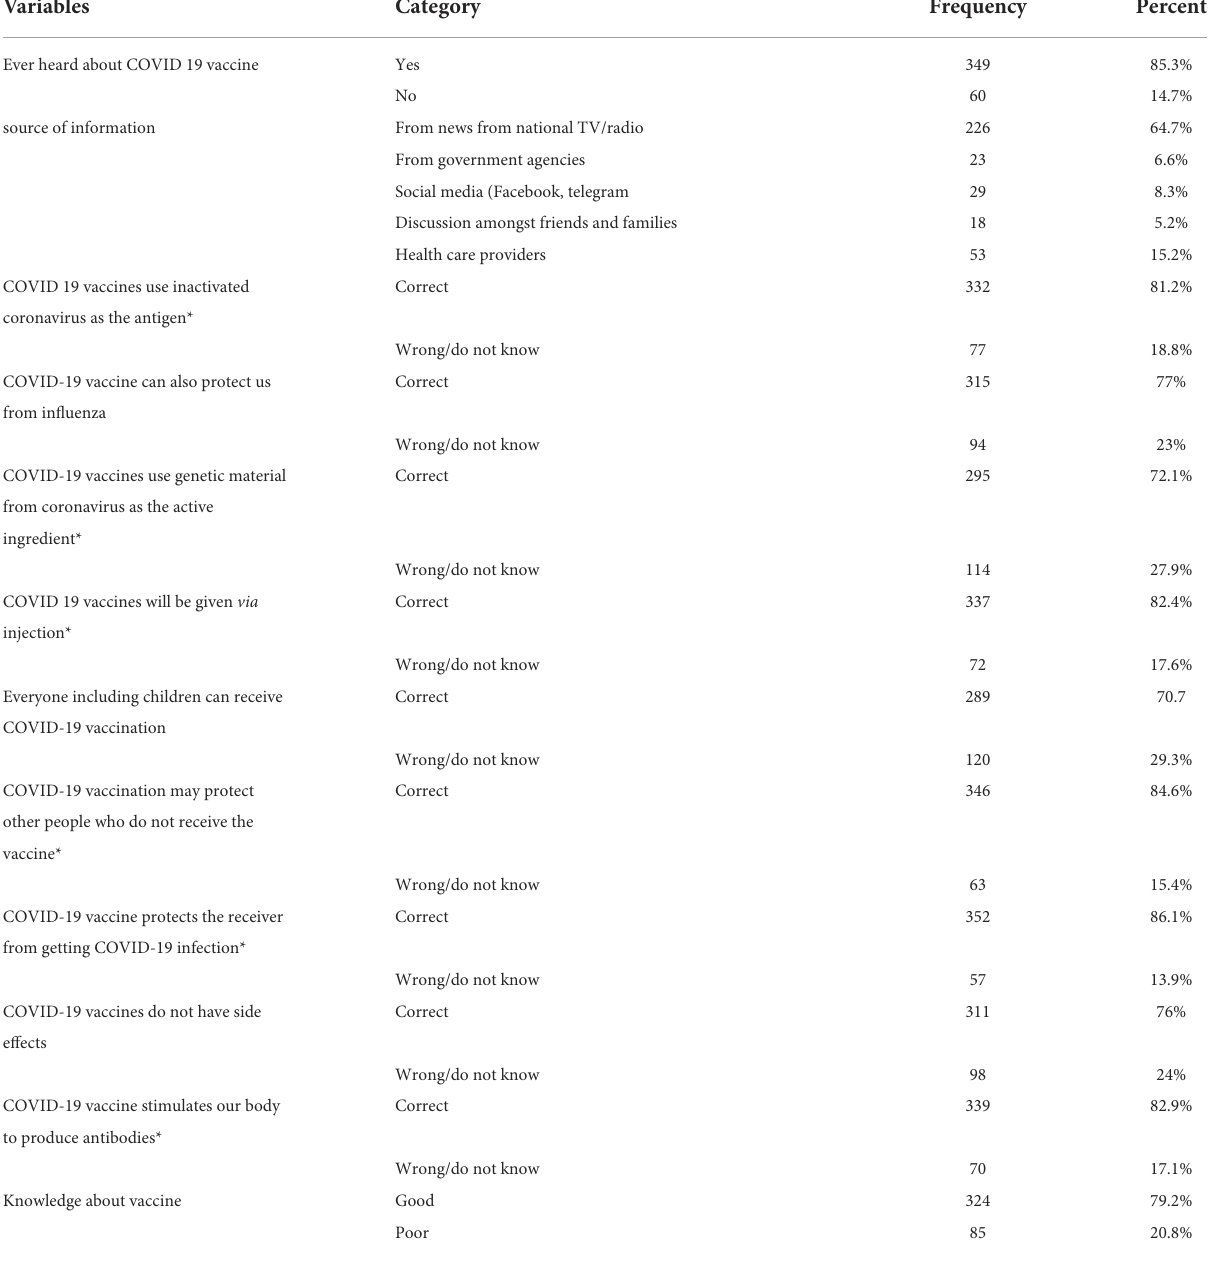
TABLE 2 Source of information and knowledge about COVID-19 vaccine among patients with chronic diseases, southern Ethiopia, 2021 ( N = 409). Variables